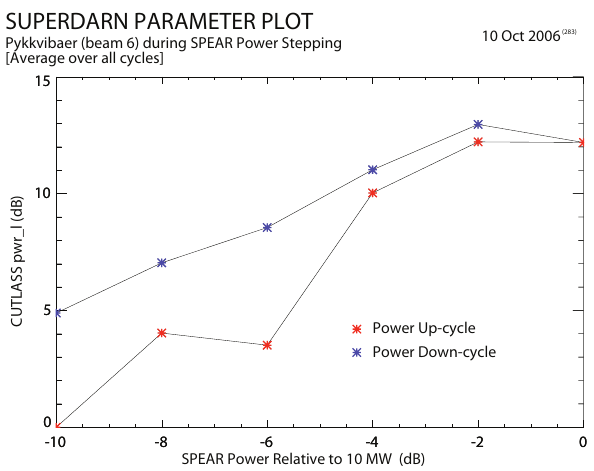
Fig. 6. The backscatter power received by the Þykkvibær radar av- eraged over all seven SPEAR power cycles. Data for the up-going and down-going parts of the cycle are plotted in red and blue re- spectively. The error bars associated with each data point are less than ±